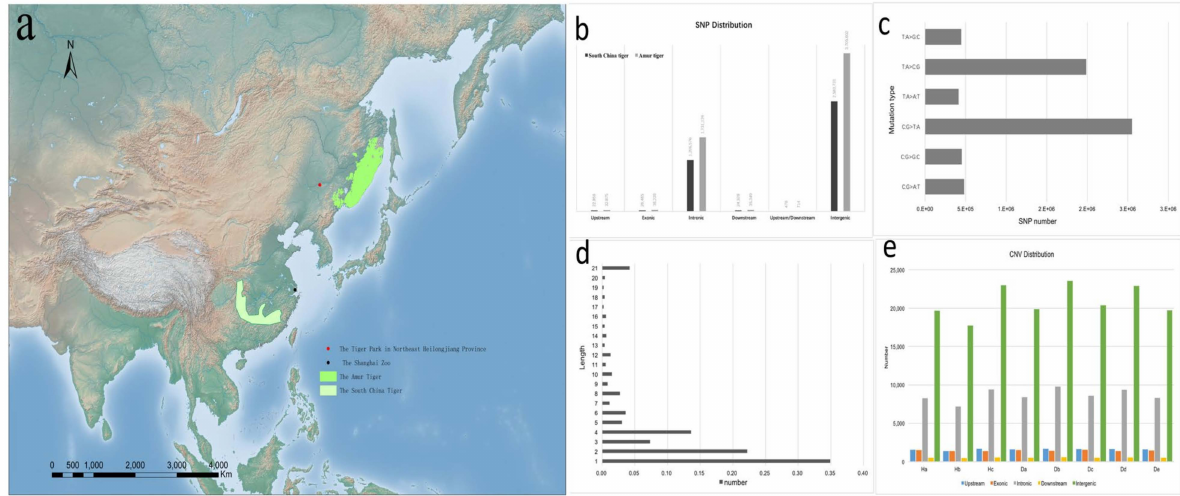
Figure 1. Distribution and variation analysis of tigers in China. ( a ) Distribution of tigers (the distribution of the South China tiger was the last result of a survey by the National Forestry and Grassland Administration; the South China tiger is now considered extinct in the wild). ( b ) SNP location and distribution. ( c ) Mutation type and quantity distribution of SNP. ( d ) InDels length distribution in genome. ( e ) CNV location and